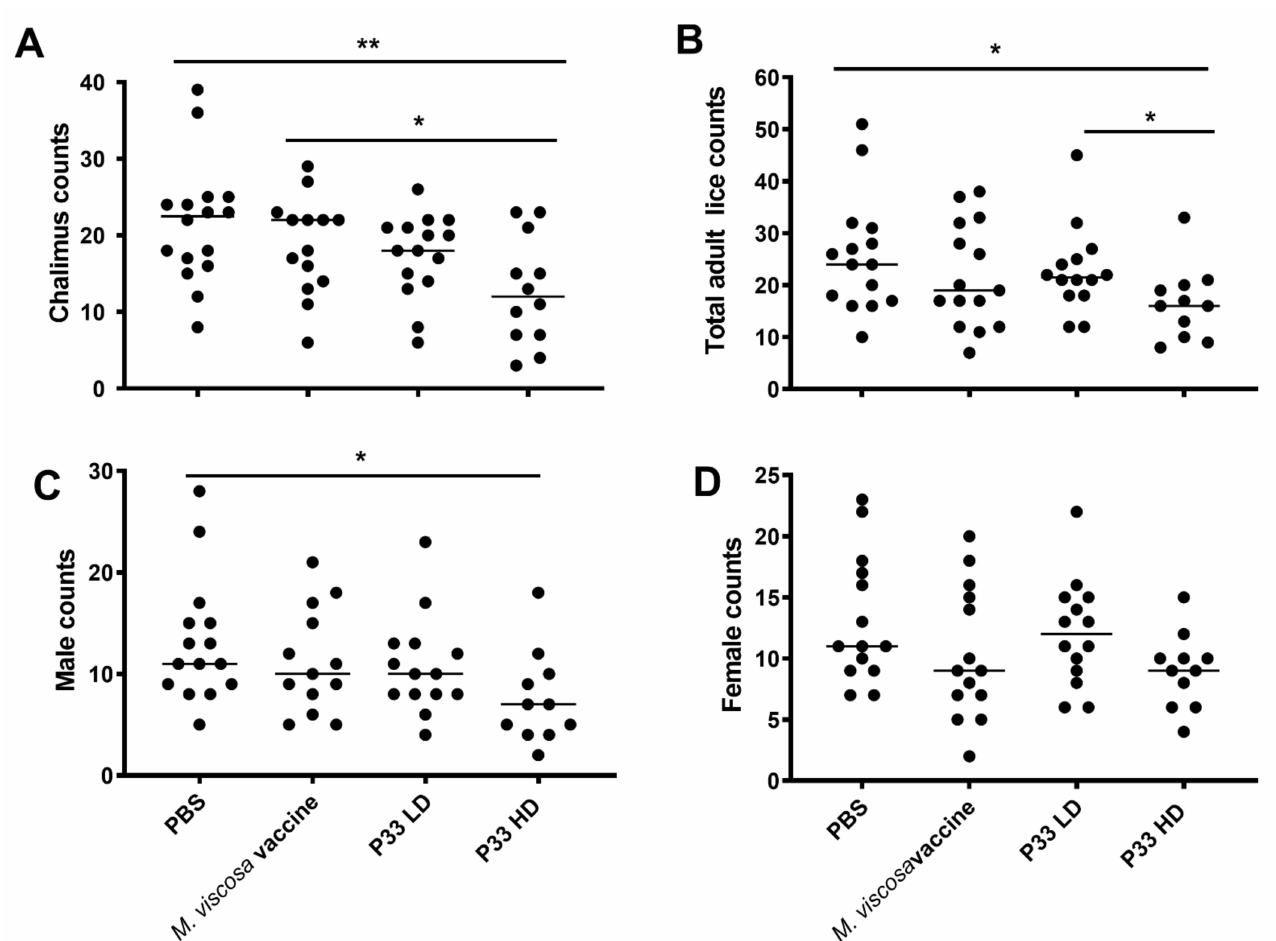
Figure 2. High dose P33 vaccination reduces lice numbers on vaccinated fish. Column scatter plots of lice count in mock-vaccinated (PBS [phosphate-buffered saline].and M. viscosa vaccine) and P33-vaccinated (LD [low dose], and HD [high dose]) Atlantic salmon fish after lice challenge. ( A ) Chalimus counts (16 weeks post-vaccination [wpv]), ( B ) Total adult lice counts (18 wpv), ( C ) Male counts and ( D ) Female counts. Horizontal lines in panels ( A , B ) represent the median lice counts in different groups. Asterisks denote significant differences (* p < 0.05; ** p <